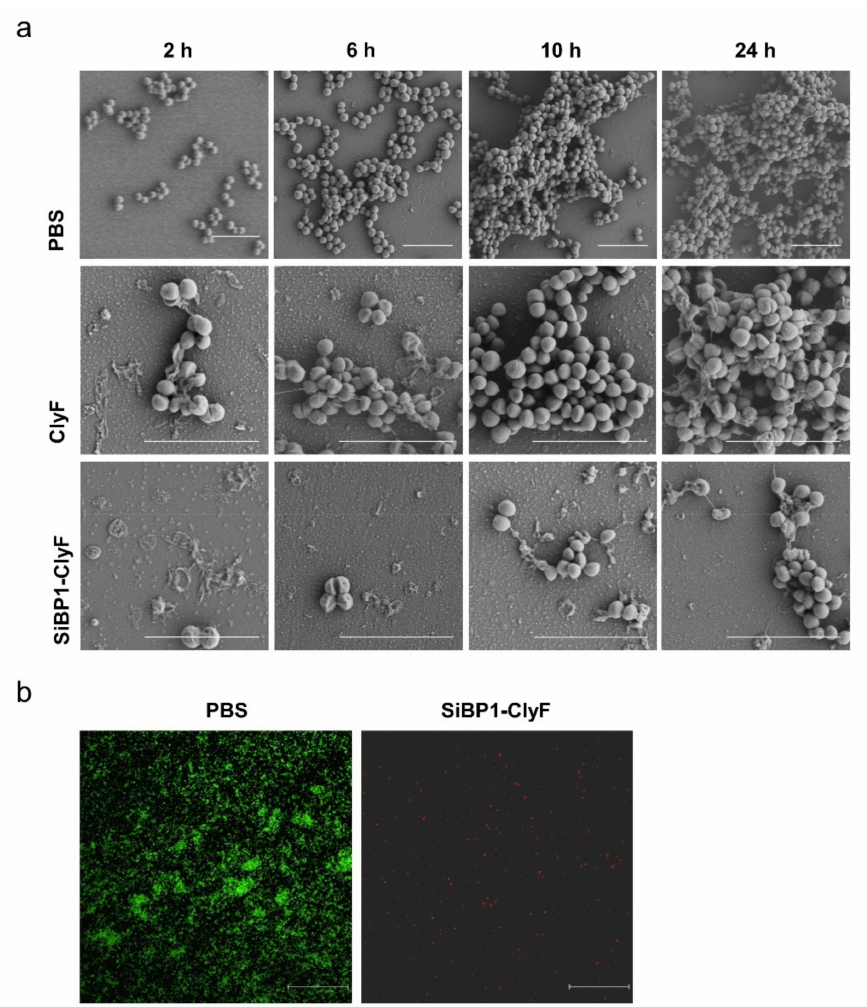
Figure 5. Antibiofouling activity of SiBP1-ClyF-immobilized surfaces against static S. aureus biofilms. ( a , b ) Analysis of antibiofilm activity of SiBP1-ClyF-immobilized surfaces. Siliconized glass coverslips were coated with 100 µ g/mL of SiBP1-ClyF for 2 h at room temperature, and then incubated with S. aureus N315 in TBSG at 37 ◦ C. Biofilms developed at 2, 6, 10, and 24 h were analyzed by a JSM-6390 scanning electron microscope ( a ). Biofilms developed at 10 h were further stained with Live/Dead bacterial viability kit and visualized by confocal fluorescence microscope ( b ). Bar scalar: 5 µ